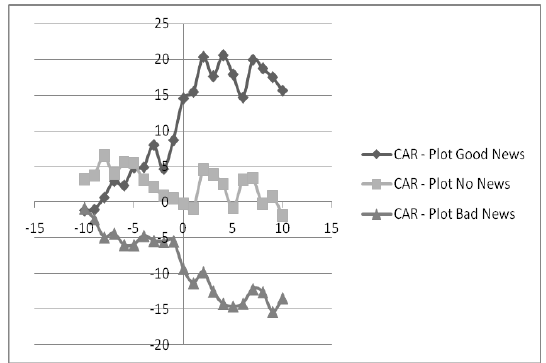
Figure 1: CAR Plot – All “Good News”, “No News” and “Bad News” for earning announcements from event day - 10 to